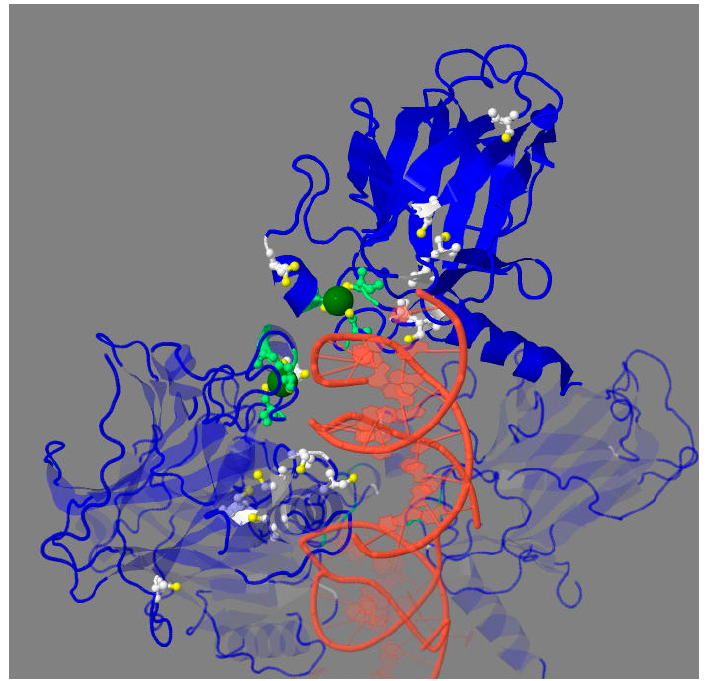
Figure 2. DNA binding of tetrameric DBD of p53 (PDB: 2AC0). Zn 2+ ion—in green, sulfur atoms—in yellow, the Zn 2+ -coordinating cysteine residues—in light green, other cysteine residues of DBD—in white. Except for the less conserved Cys229, all cysteines are located on the DNA-binding surface of DBD. For clarity, the cysteine residues and Zn 2+ ions are shown only in two out of four DBDs.